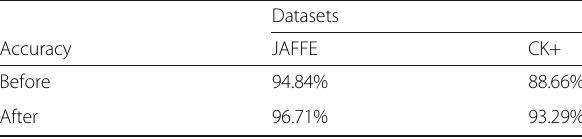
Table 1 Increase of proposed accuracy method using image preprocessing